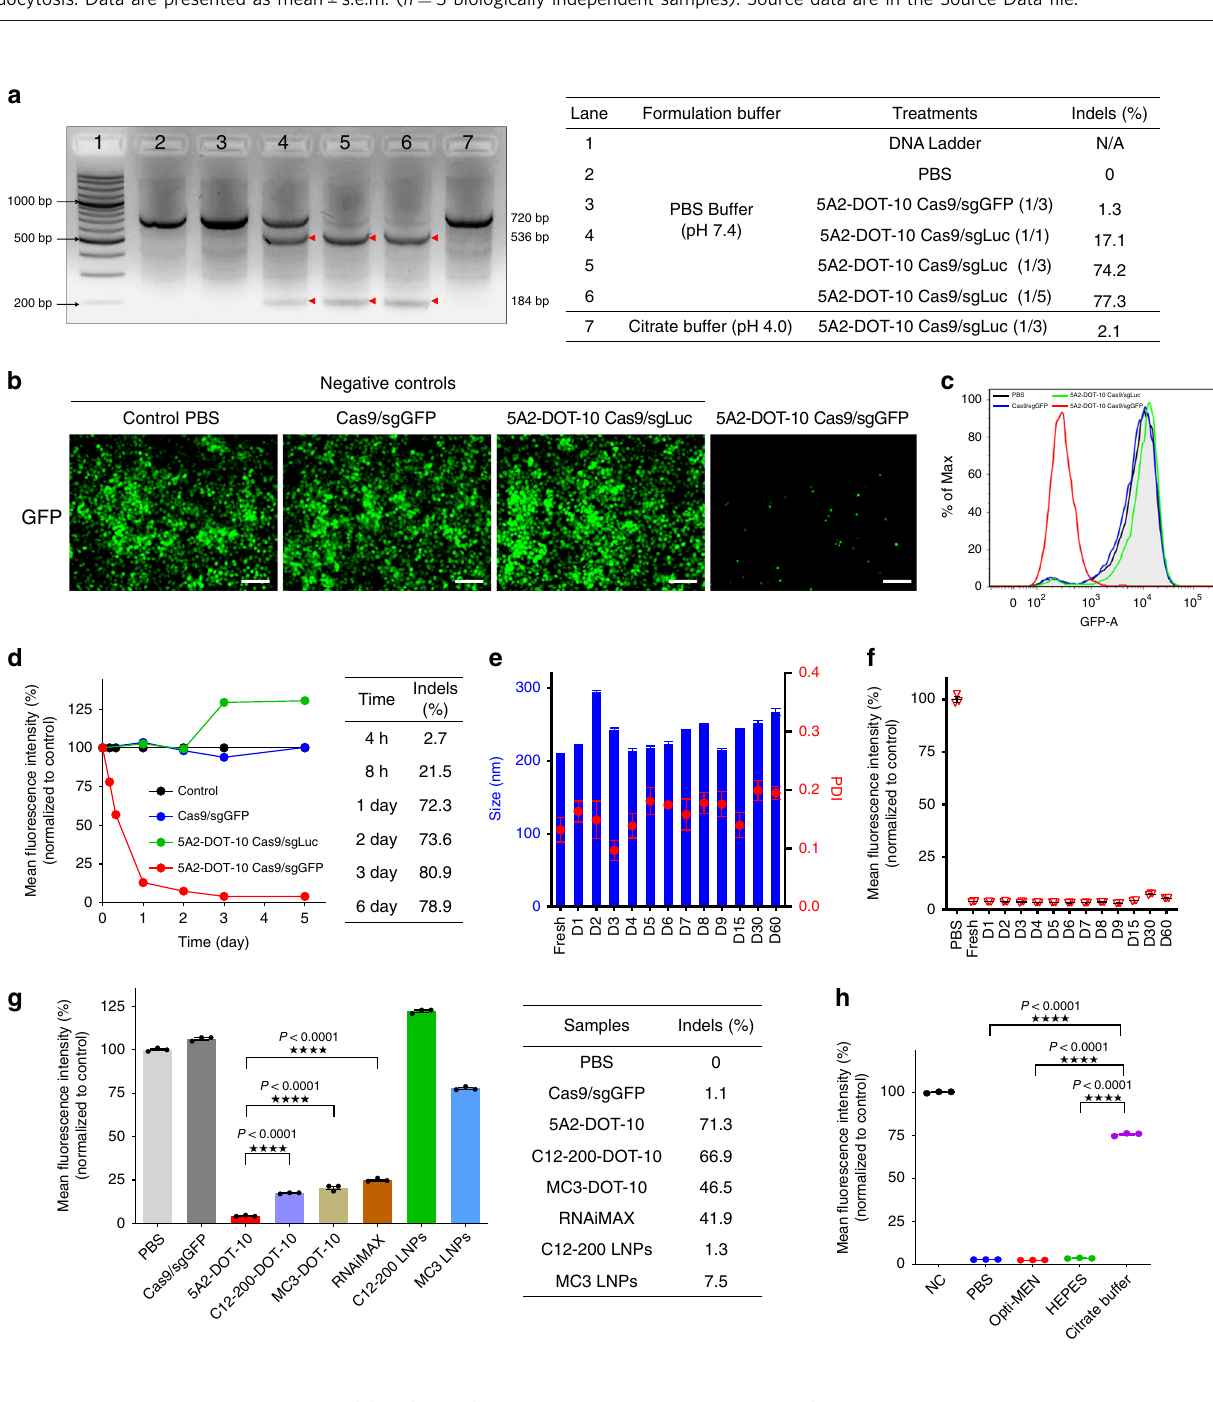
Fig. 1 A modular approach was developed to enable systemic nanoparticle delivery of CRISPR-Cas9 RNPs for tissue-speci fi c genome editing. a Addition of a permanently cationic supplemental component (e.g., DOTAP) into traditional LNP formulations enabled encapsulation and protection of Cas9/sgRNA complexes using neutral buffers during nanoparticle formation. Precise tuning of the DOTAP percentage mediated tissue-speci fi c gene editing. b Size distribution of Cas9/sgLuc RNPs prepared in PBS buffer (pH 7.4) and citrate buffer (pH 4.0). The size increase is likely due to denaturization. c Size distribution of 5A2-DOT-10 encapsulating Cas9/sgLuc RNPs prepared in PBS and citrate buffer. 5A2-DOT-10 prepared without RNPs was used as control. d Size distribution of Cas9/sgRNA RNPs with Cas9/sgLuc molar ratio of 1/1, 1/3, and 1/5. e Size distribution of 5A2-DOT-10 encapsulating Cas9/ sgLuc with molar ratio of 1/1, 1/3, and 1/5. f Zeta potential of Cas9/sgRNA RNPs showing decreasing charge. Data are presented as mean ± s.e.m. ( n = 3 biologically independent samples). g No signi fi cant difference of zeta potential was observed for 5A2-DOT-10 encapsulating Cas9/sgLuc with different molar ratios. Data are presented as mean ± s.e.m. ( n = 3 biologically independent samples). h Time-dependent cellular uptake of 5A2-DOT-10 LNPs encapsulating EGFP-fused Cas9/sgRNAs showing cytoplasmic release and gradual entry into the nucleus ( n = 3 biologically independent samples). Scale bar: 10 μ m. Red arrows show distribution of EGFP-fused Cas9/sgRNAs inside cells. i Inhibition of 5A2-DOT-10 LNP uptake was studied using speci fi c endocytosis inhibitors. Amiloride (AMI): inhibitor of macropinocytosis; chlorpromazine (CMZ): inhibitor of clathrin-mediated endocytosis; Genistein (GEN): inhibitor of caveolae-mediated endocytosis; Methyl- β -cyclodextrin (M β CD): lipid rafts-mediated endocytosis; 4 degree: energy-mediated endocytosis. Data are presented as mean ± s.e.m. ( n = 3 biologically independent samples). Source data are in the Source Data fi